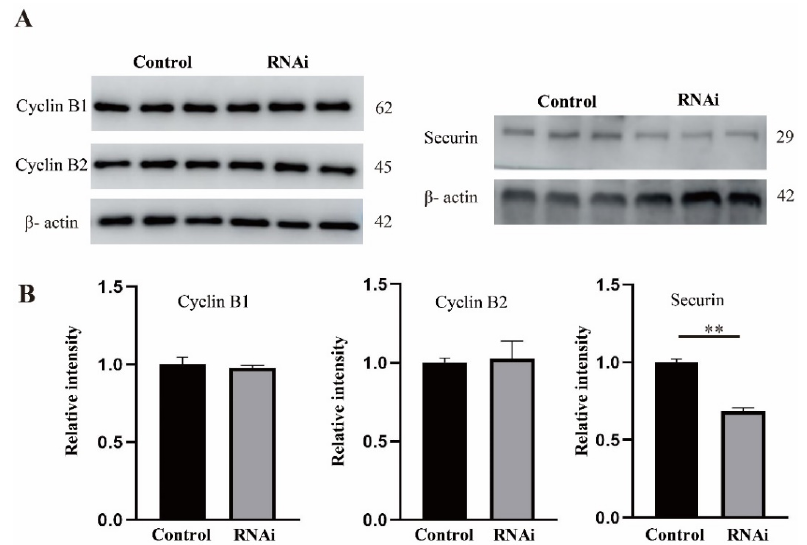
Figure 6. Rae1 knockdown significantly decreases the protein level of securin in MI stage oocytes. After Rae1 knockdown, GV stage oocytes were cultured for 8 h (MI stage) after release from IBMX arrest and were collected for the Western blotting of cyclin B1, cyclin B2, and securin. ( A ) Three independent repeat results of securin, cyclin B1, and cyclin B2 by Western blotting. ( B ) The relative intensity of securin, cyclin B1, and cyclin B2 were compared in the control group and Rae1 knockdown group. ** p < 0.01. The data are presented as mean ± SEM of at least three independent experiments.